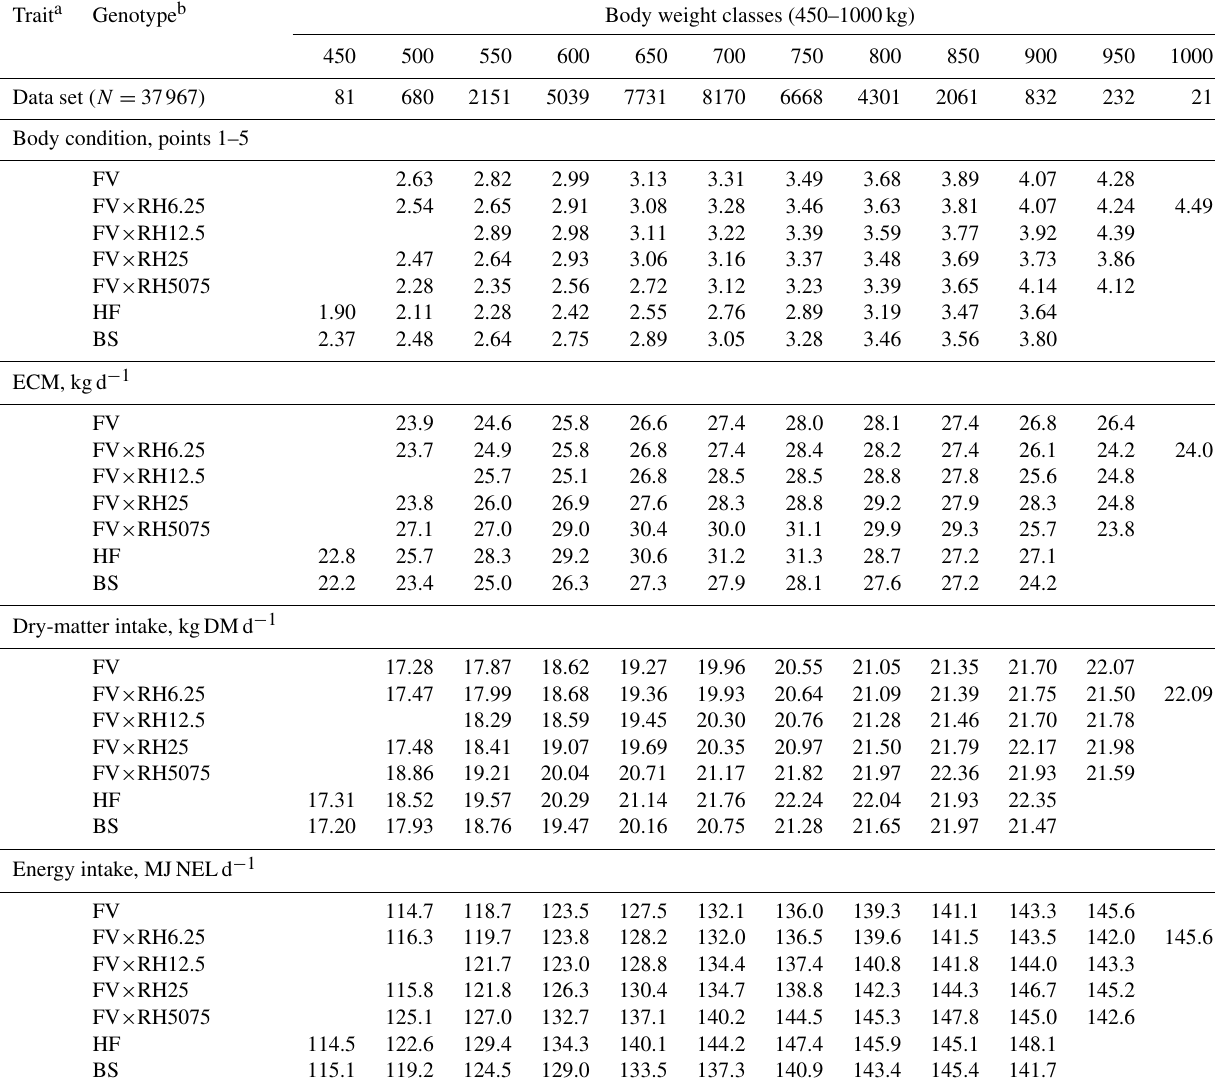
Table 1. Effect of genotype × body weight on BCS, energy-corrected milk, feed and energy intake (least squares means). Trait a Genotype b